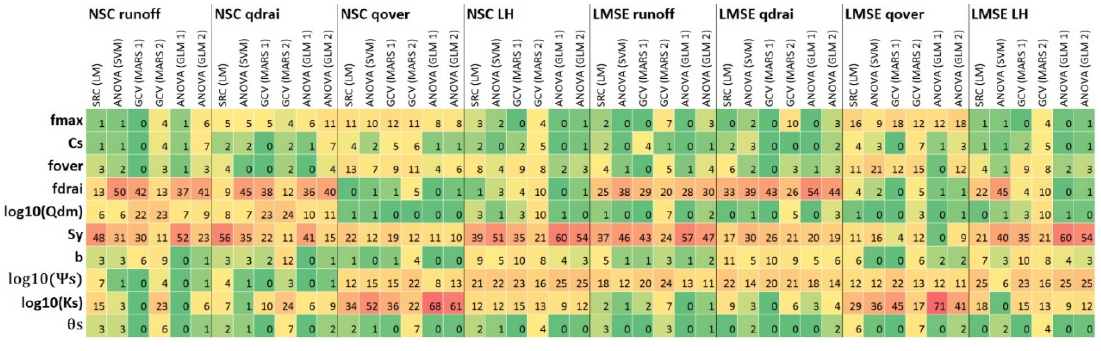
Figure 3. Sensitivity scores for different response variables/metrics and SA approaches.